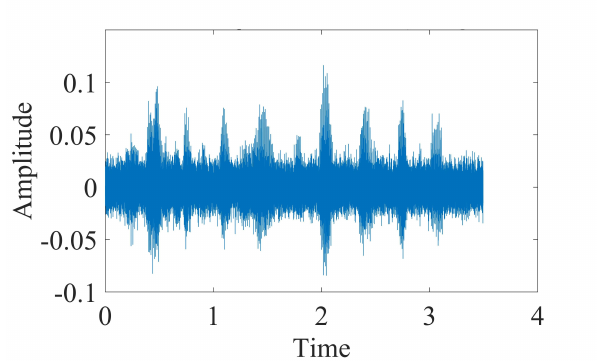
Figure 4. Time domain figure of noisy original signal.